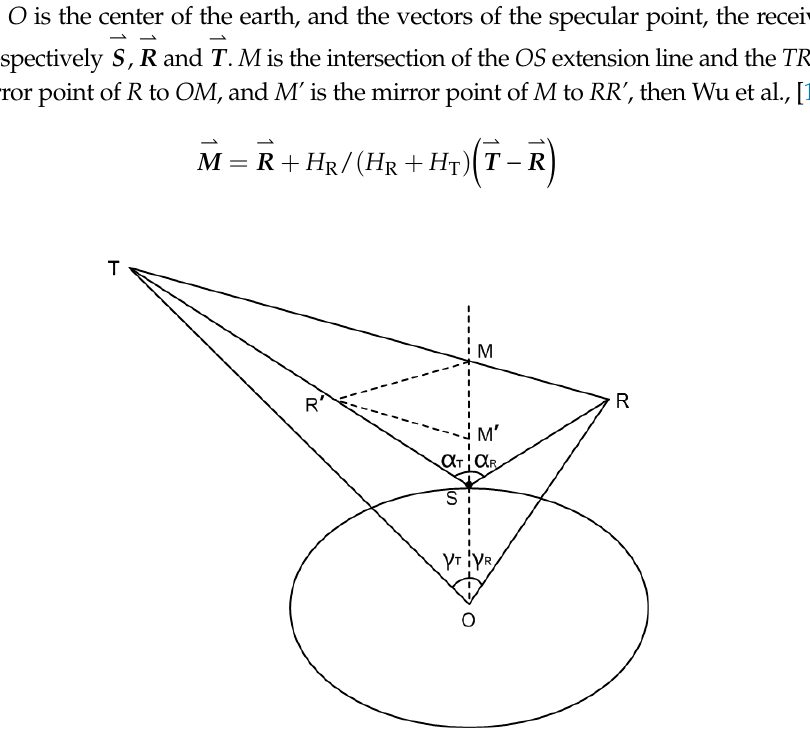
Figure 2. The GNSS-R specular reflection point positioning geometry Figure 2. The GNSS ‐ R specular reflection point positioning geometry [13].